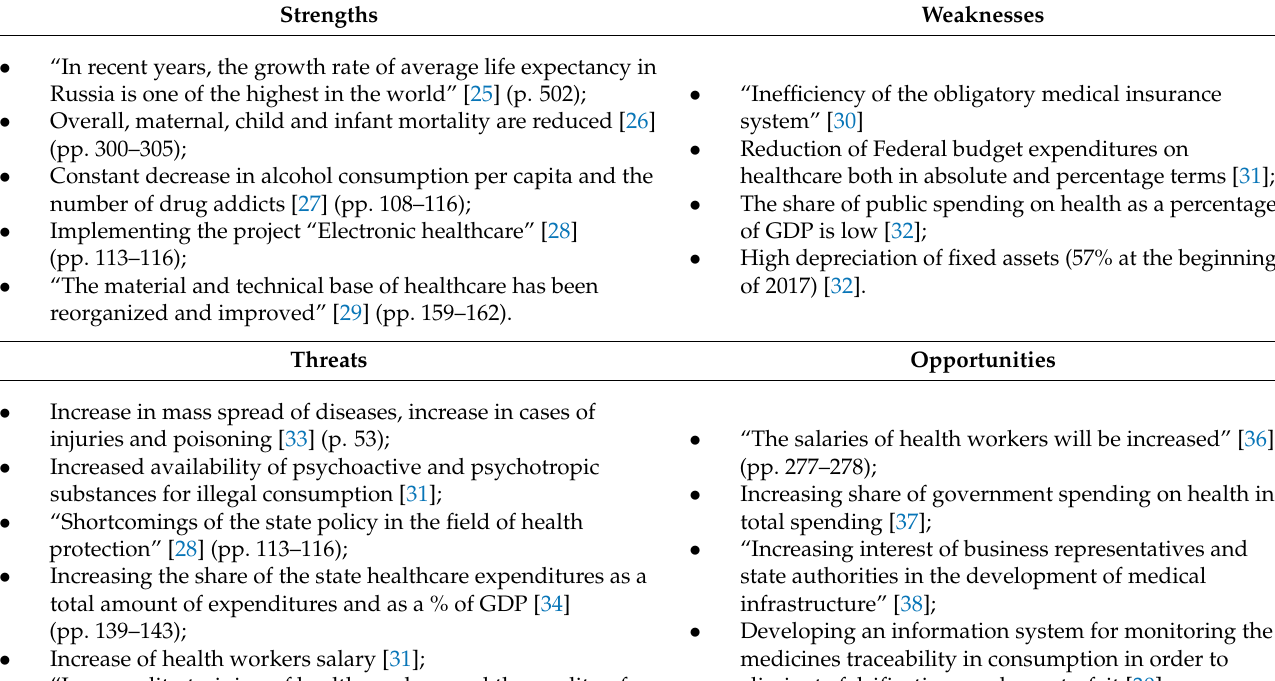
Table 2. SWOT analysis of healthcare system in